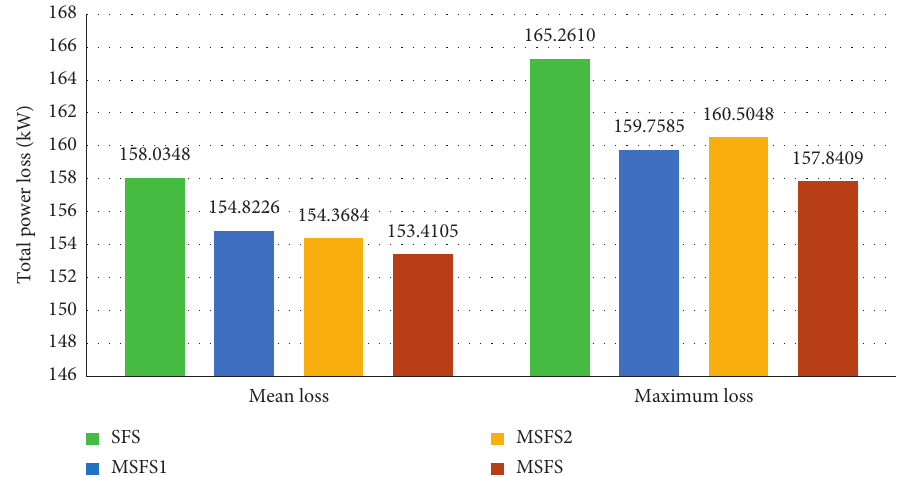
Figure 23: Mean and maximum power loss of 50 trial runs obtained by SFS methods for case 2 of the 85-bus system.